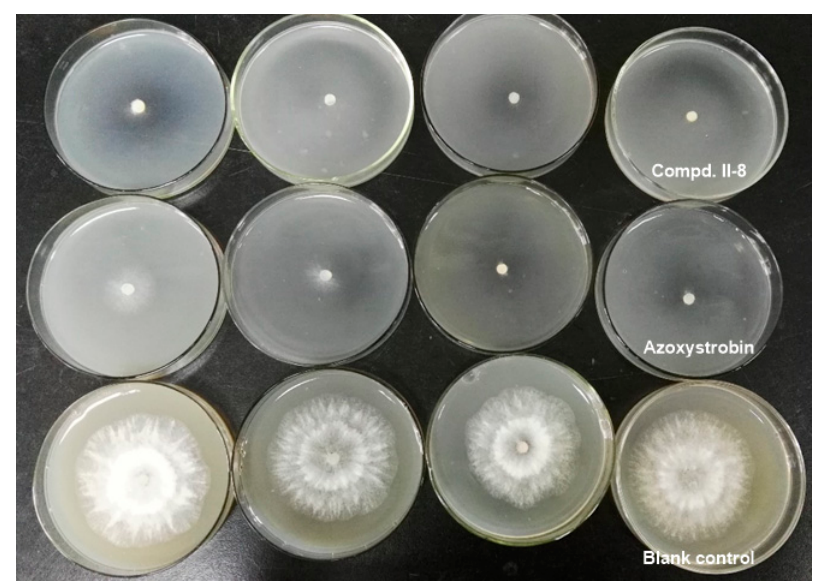
Figure 5. Mycelial growth of Pestalotiopsis theae using compound II-8 and azoxystrobin at the different concentration of 6.25, 12.5, 25 and 50 mg/L.